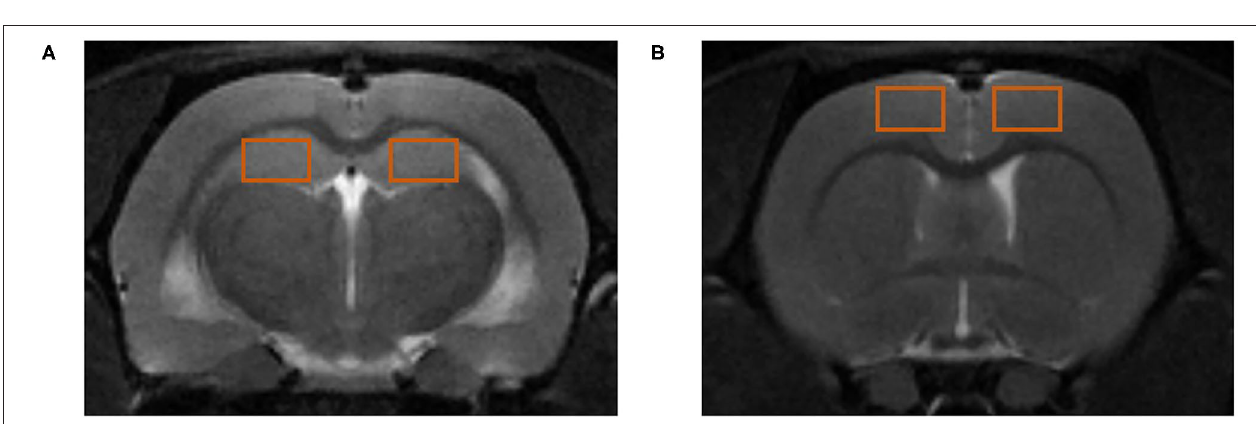
FIGURE 2 | Regions of interest (ROIs) for magnetic resonance (MR) detection. (A) ROIs in the hippocampus (HP). (B) ROIs in the prefrontal cortex